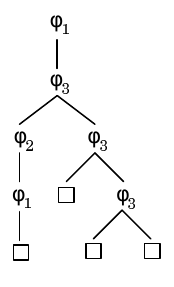
Fig. 4: A derivation tree in